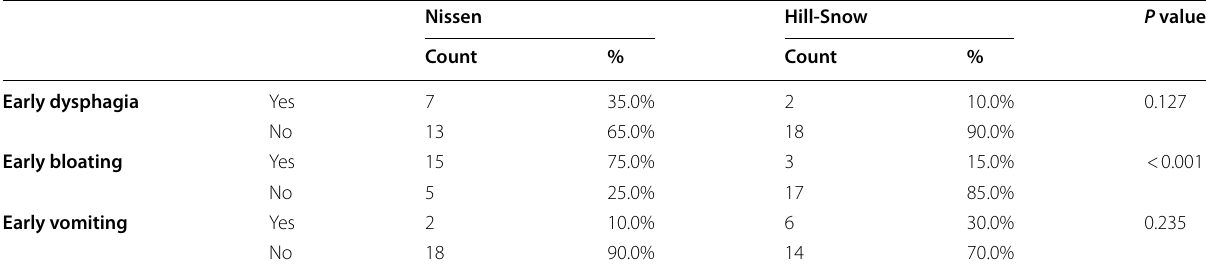
Table 3 Early postoperative observations for studied groups